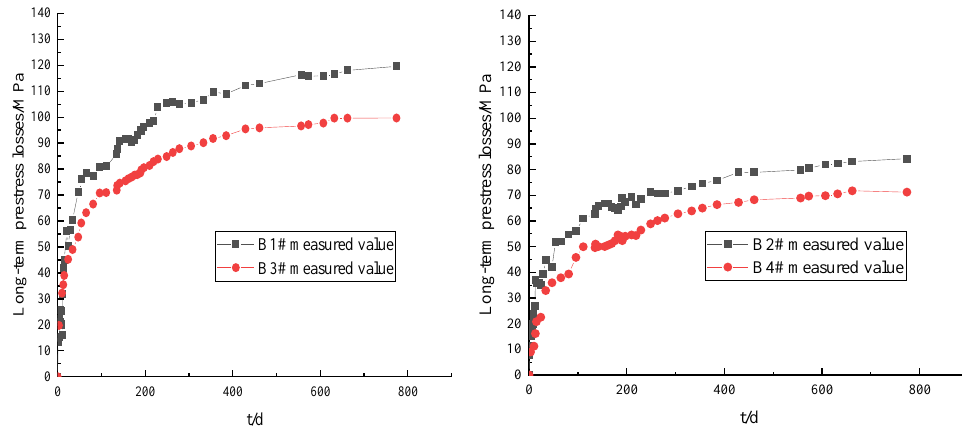
Figure 6. Comparison of long-term prestress losses at different tension ages.